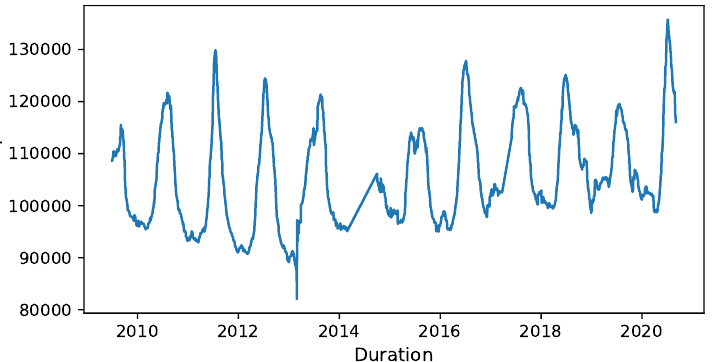
Figure 3. Trends of water consumption for city of London, Canada, from 2010 to 2020 [29].